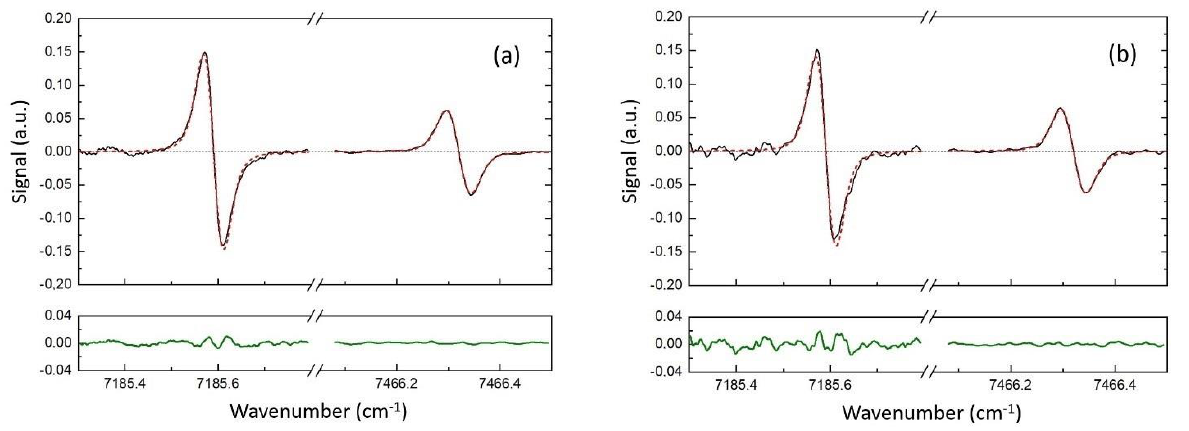
Figure 7. Fitting of the spectra measured by the log-WMS-1 f technique in one scan with rotating disk off ( a ) and disk on ( b ). The measured spectra — black lines; the best-fit simulated spectra — red off ( a ) and disk on ( b ). The measured spectra—black lines; the best-fit simulated spectra—red lines; lines; residuals — green lines. residuals—green